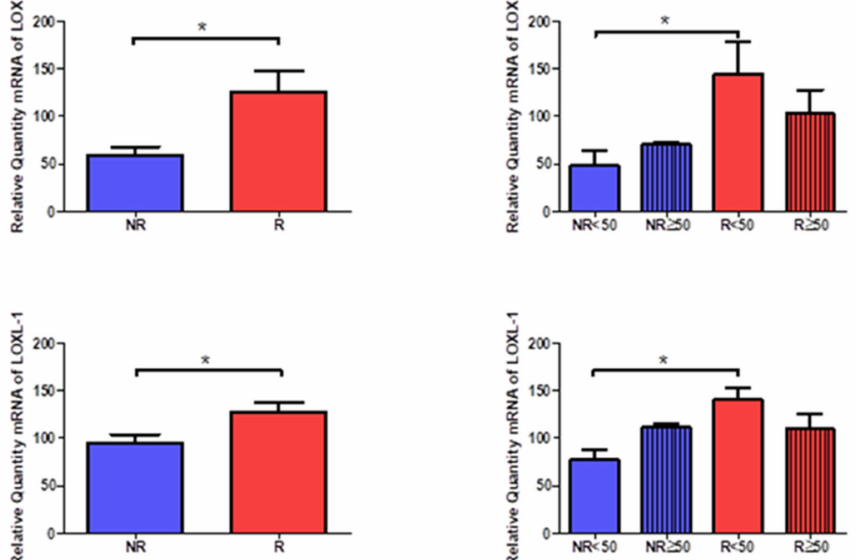
Figure 16. Expression levels of the gene for LOX and LOXL-1 quantified by RT-qPCR of patients without reflux (NR) and with reflux (R), as well as by their ages. * p < 0.05. The protein study showed that the highest percentage of positive expression was detected in the groups with venous reflux for LOX and LOXL-1 (LOX = NR = 51.72%, R = 88.89%, LOXL-1 = NR = 62.07%, R = 86.42%). Taking age into account, the percentages for LOX and LOXL-1 were similar, even equal in the case of R < 50 patients (LOX = NR < 50 = 46.15%, NR > 50 = 56.25%, R < 50 = 96.88%, R > 50 = 83.67%, LOXL-1= NR < 50 = 61.54%, NR > 50 = 62.50%, R < 50 = 96.88%, R > 50 =